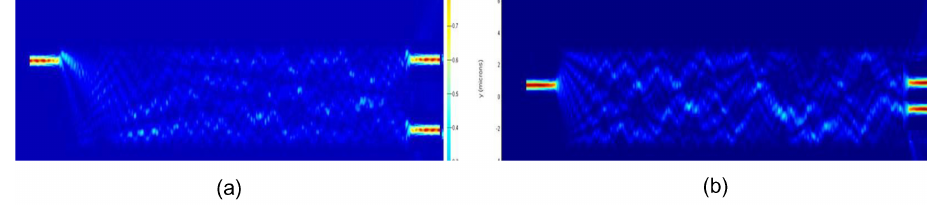
Figure 3. Electric field inside the the access waveguides and MMI 1 where the input is fed through ( a ) port a i 1 and ( b ) port a i 2 . Two-dimensional FDTD numerical method was used to optimize and